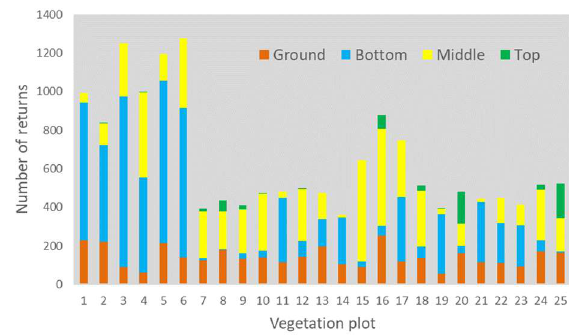
Figure 4. Number of returns in Ground, bottom vegetation (0-50 cm), middle vegetation (50-100 cm) and top vegetation (>100 cm) layers in each vegetation